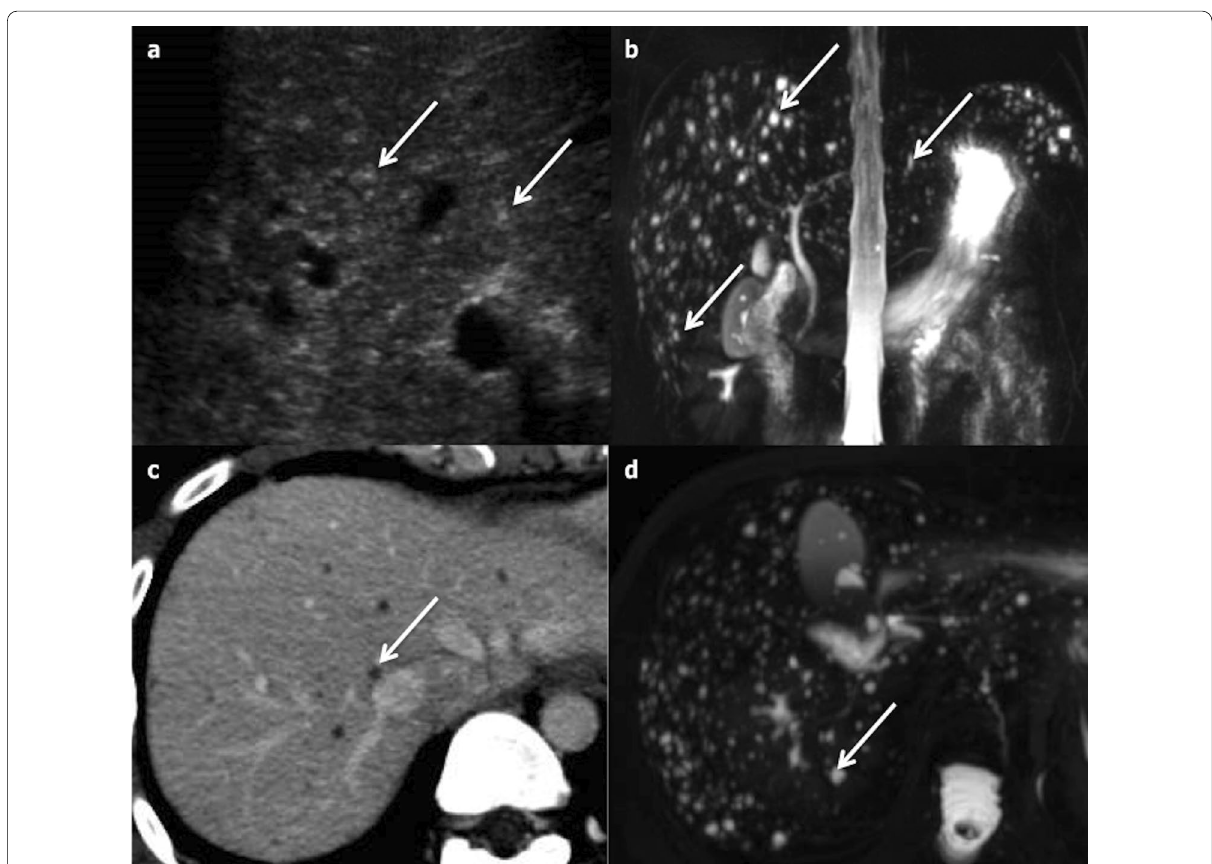
Fig. 9 Bile duct hamartomas in a 52-year-old female. a Multiple hyperechoic round nodules (arrows) at ultrasonography, displaying a “snowstorm” pattern. b Coronal magnetic resonance cholangiopancreatography shows several small hyperintense nodules, which do not communicate with the biliary tract (arrows). c Axial computed tomography on portal venous phase shows bilobar small round-shaped hypoattenuating nodules, which can be better detected with an axial magnetic resonance cholangiopancreatography sequence ( d